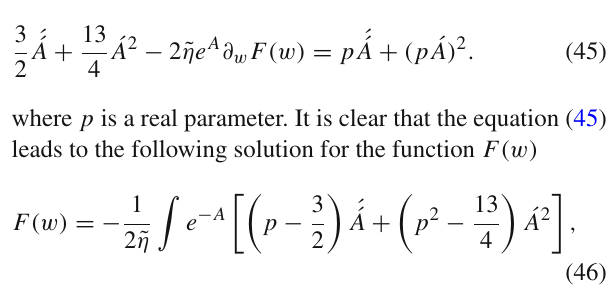
Fig. 3 The profile of the potential V 0 ( z ) (solid line) and the zero mode α ( ¯ w) (dotted line) for s = 1, H = 1 / 2, p = 0